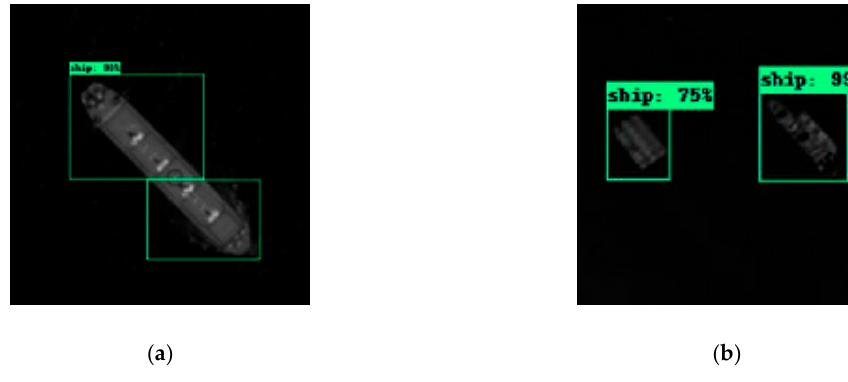
Figure 8. The diagram of judgement used to calculate the test result. ( a ) Schematic diagram of the same ship being detected twice. ( b ) Schematic diagram of multiple parallel ships being detected only once. We considered that only one ship was detected if these conditions occur.